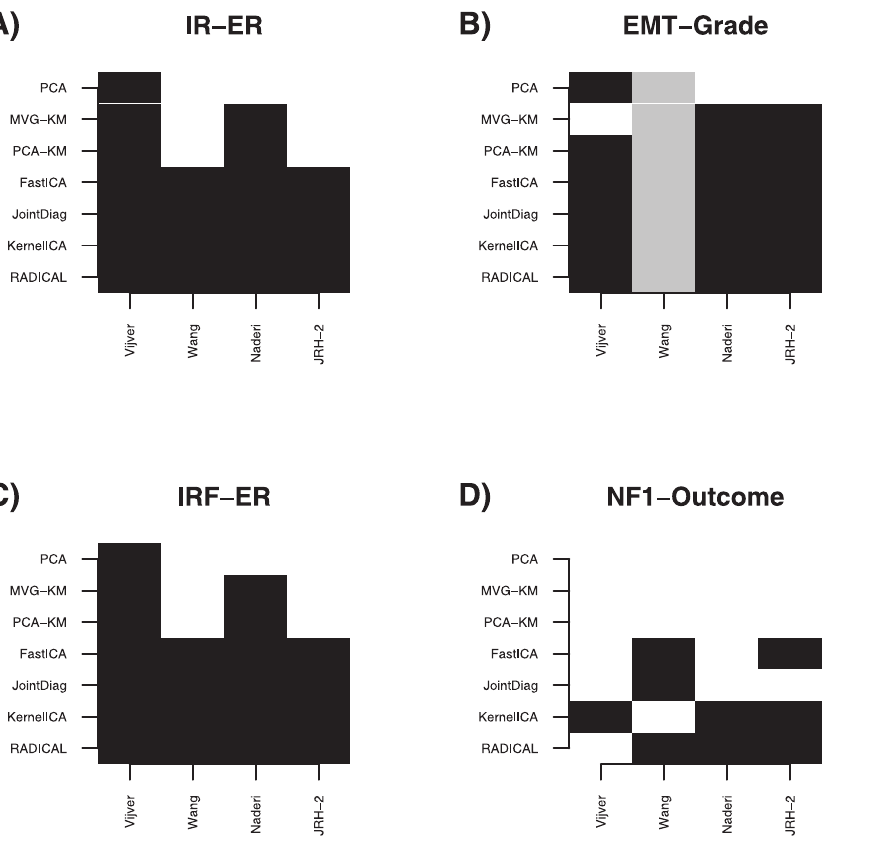
Figure 7. Inter-Method Comparison of Selected Associations of Pathways and Regulatory Modules with Breast Cancer Phenotypes The ability of the various methods to capture novel biological associations between pathways/regulatory modules and phenotypes is represented as a binary heatmap across methods and cohorts. (A) Immune response pathway and ER status, (B) EMT-pathway and grade, (C) IRF and ER status, (D) Neurofibromin-1 and clinical outcome. Black denotes a statistically significant association between a pathway/regulatory module and the phenotype in question, white means no evidence of an association.